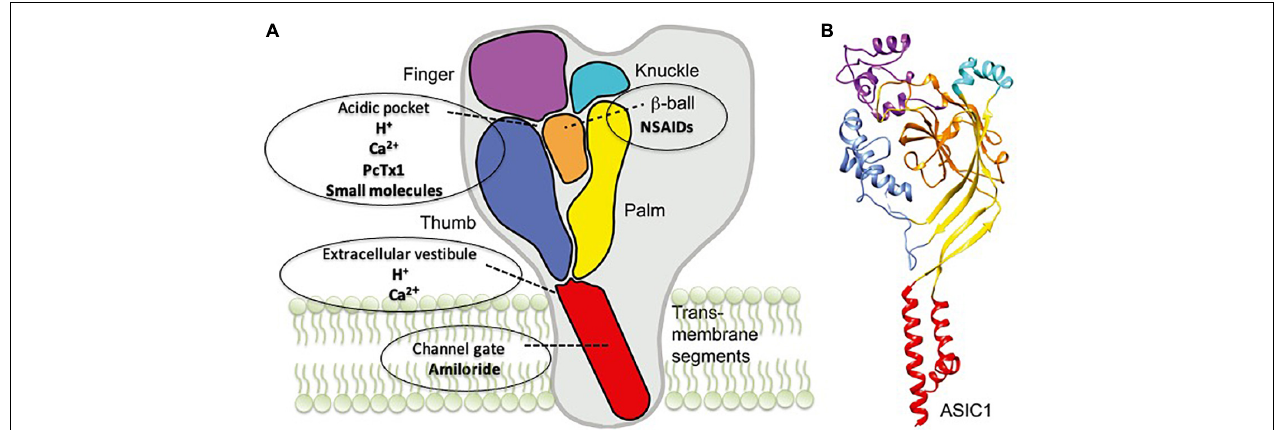
FIGURE 1 | Acid-sensing ion channel 1a (ASIC1a) structure and the binding sites of its modulators. (A) A schematic view of the ASIC1 subunit highlighting the different domains: finger (purple), knuckle (turquoise), β -ball (orange), palm (yellow), and thumb (blue) and transmembrane domains (red). The binding sites for the different drugs are also indicated. (B) Crystal structure of an ASIC1 subunit obtained from chicken ASIC1 binding Mit-Tx (Baconguis et al., 2014). The domains are colored as in panel A . Readapted from Boscardin et al.